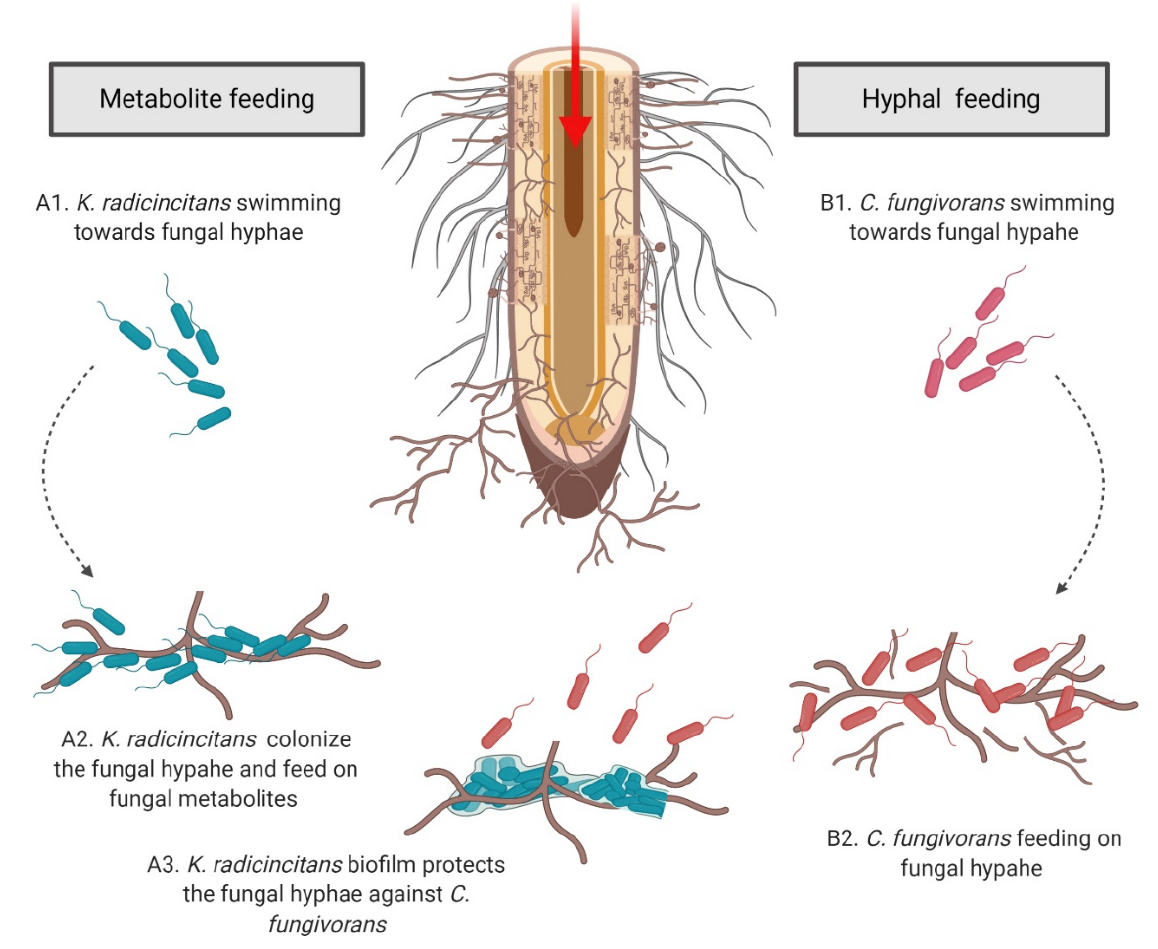
Figure 9. A conceptual model of hyphal protection and bacterial feeding strategies employed by K. radicincitans and C. fungivorans . Photosynthetically fixed carbon enters the rhizosphere via roots and fungal hyphae. Metabolite feeding: K. radicincitans colonizes the fungal hyphae and forms a thick biofilm while feeding on fungal metabolites. The biofilm confers protection to the fungal hyphae against C. fungivorans on solid agar medium (A1–A3). Hyphal feeding: